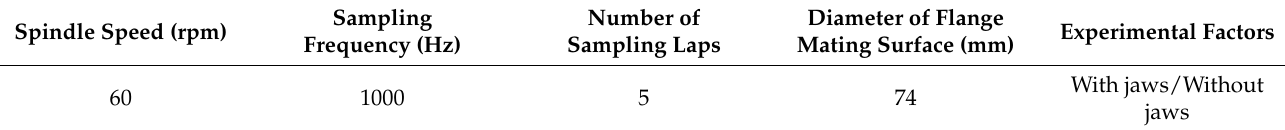
Table 3. Single-factor experiment of three-jaws